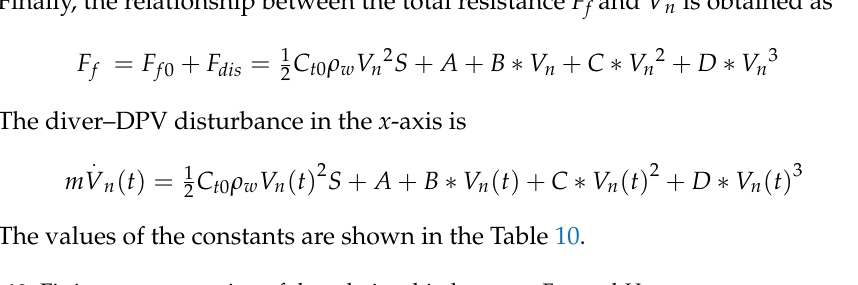
Table 10. Fitting curve equation of the relationship between F dis and V n